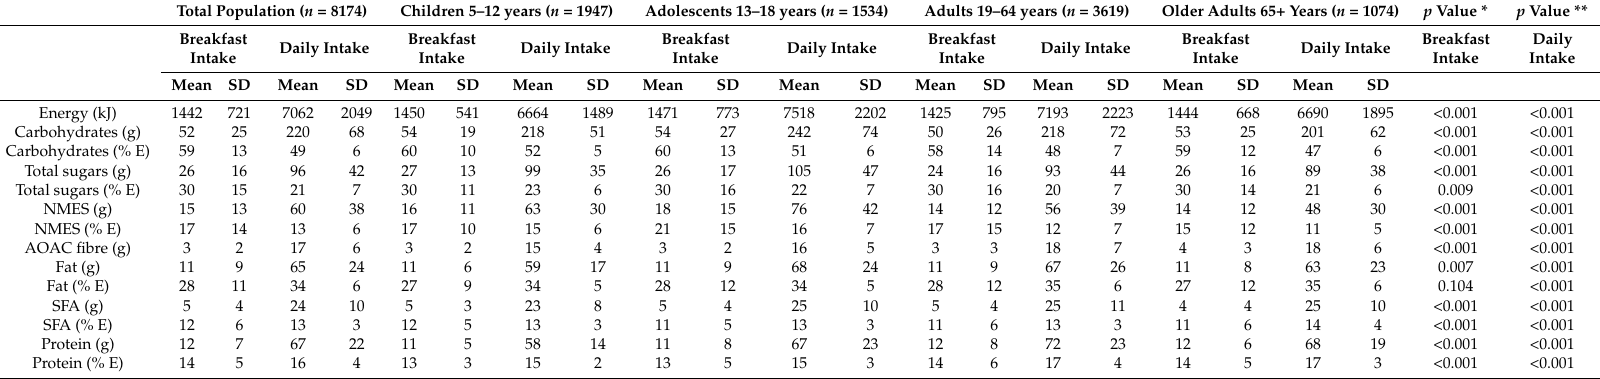
Table 1. Mean energy and macronutrient intakes at breakfast and for the total day in the total population and by age